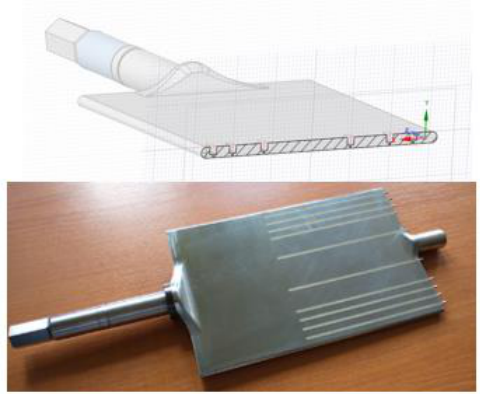
Figure 3. Static pressure probes mounted in the blades.